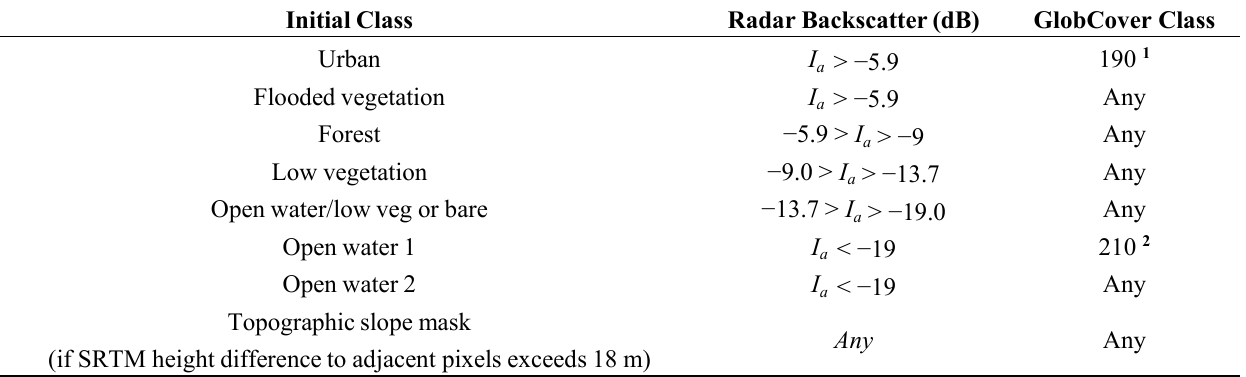
Table 1. Initial class identification from multi-temporal average radar backscatter and ESA GlobCover land cover classification